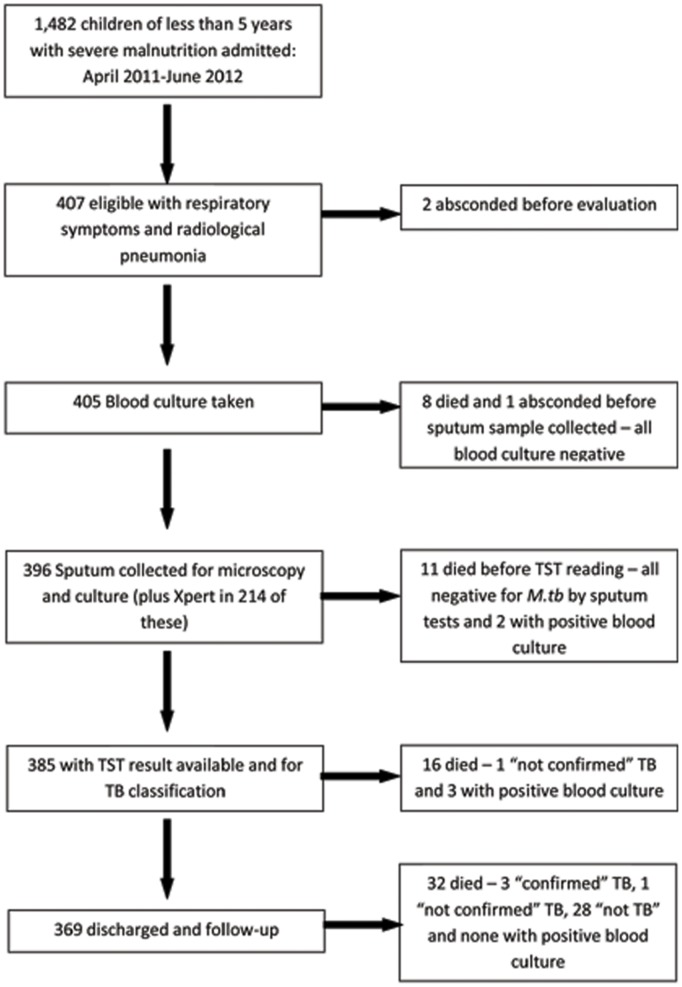
Flowchart of enrolment, investigations and outcome.